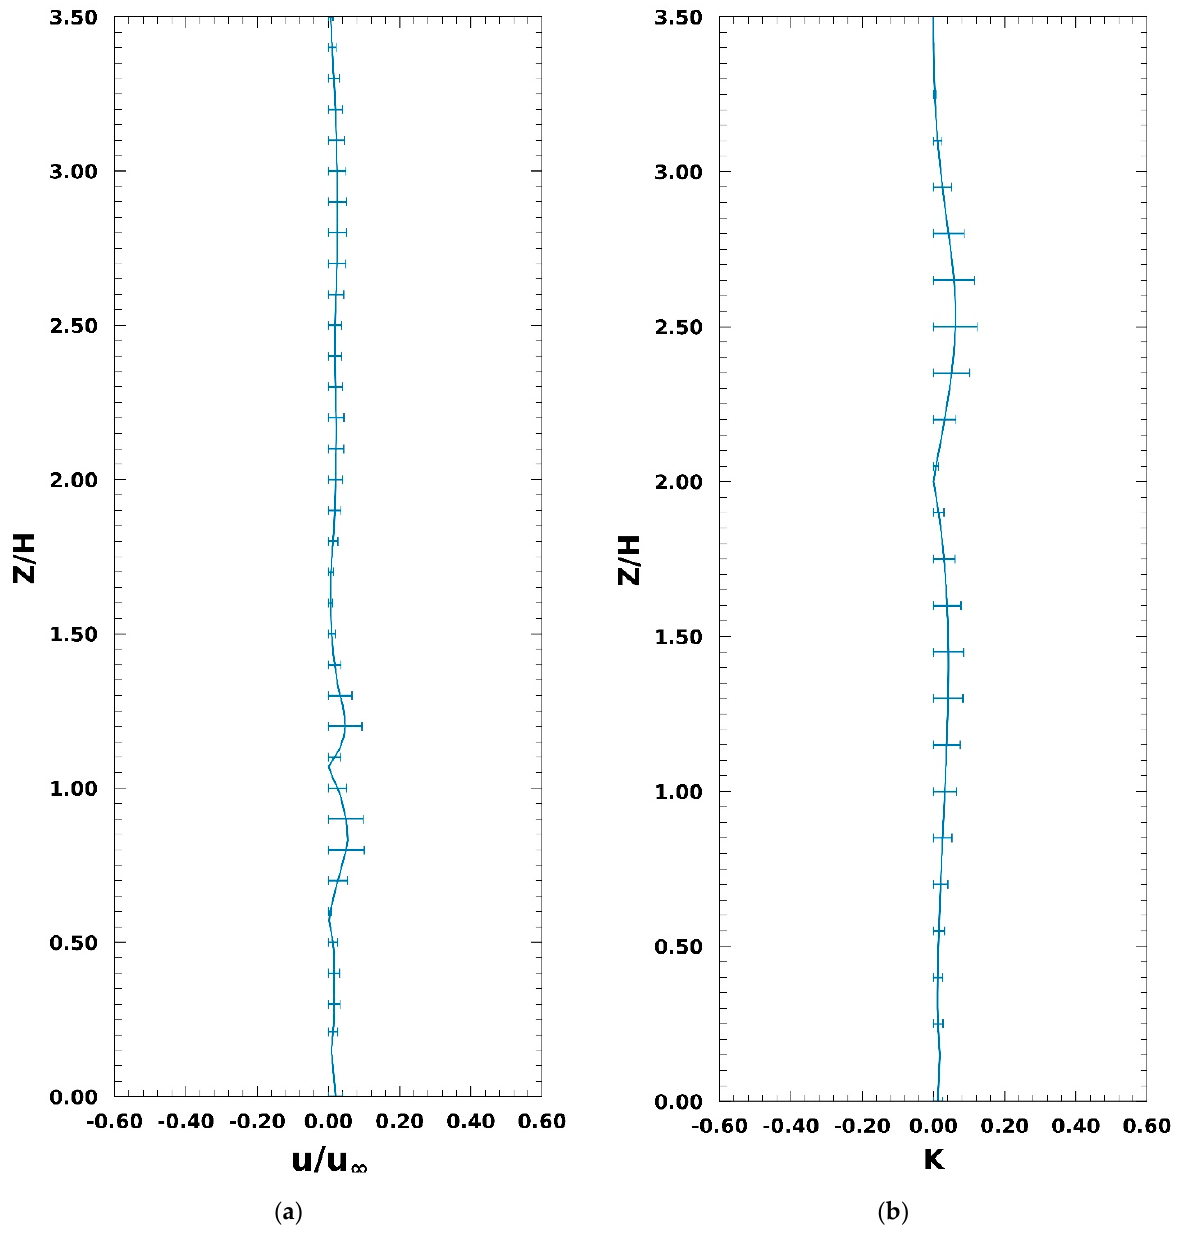
Figure 6. GCI error bars estimated from the fine to medium grids for Scenario A: ( a ) for the normalized velocities u x /u ∞ and ( b ) for the normalized concentration of the pollutant at the axial position of 0.5 H from the rear surface of the building.